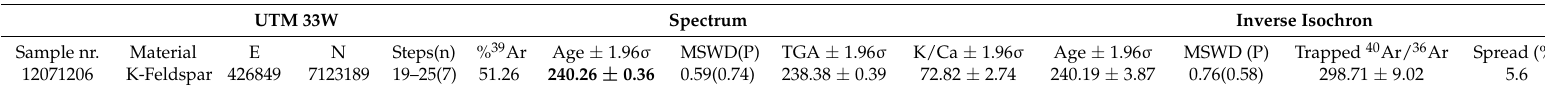
Table 3. Results of 40 Ar/ 39 Ar K-feldspar dating.